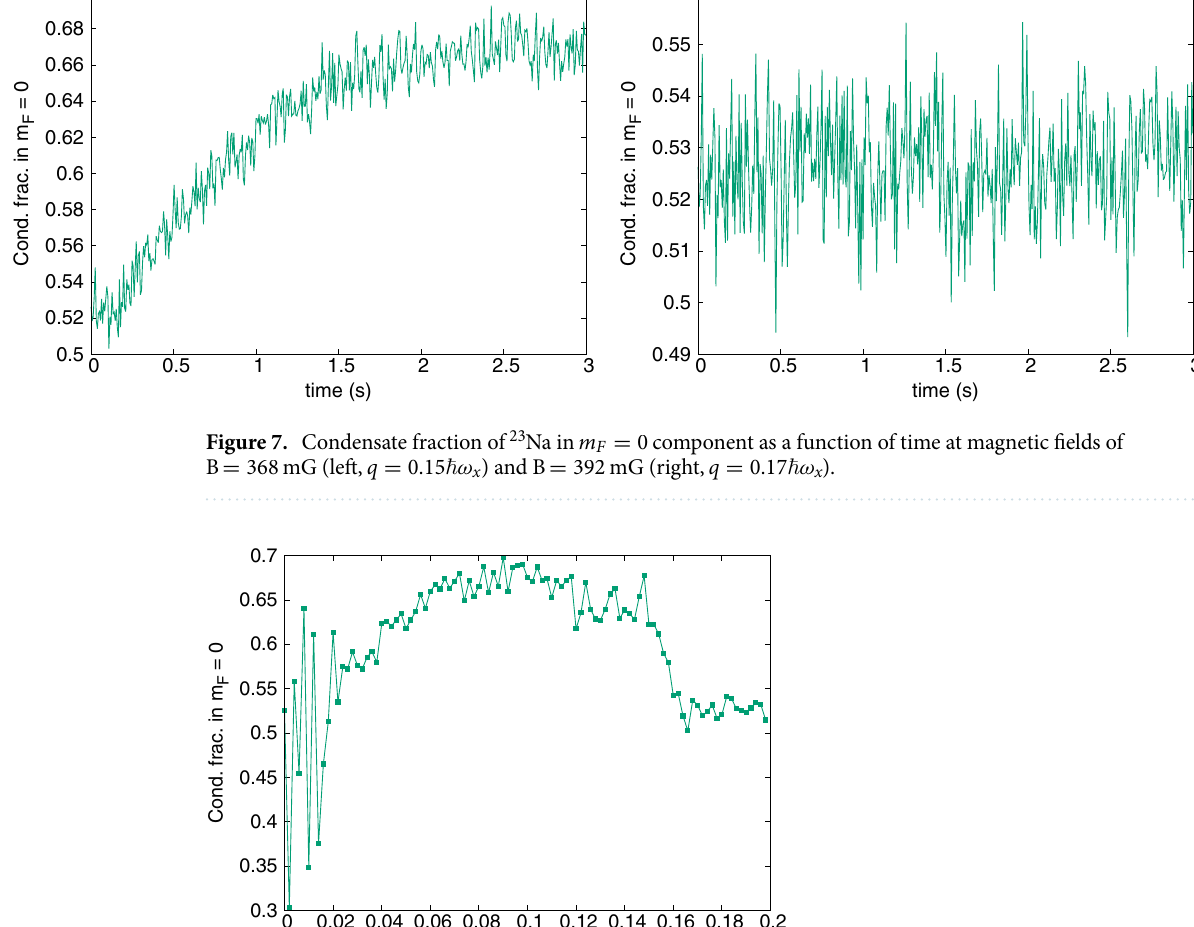
q [osc. un.] 0 after one 1 s cycle, as a function of the applied quadratic Figure 8. Final 23 Na condensate fraction in m F = 0.15 (cid:31) ω x . At the lowest q (cid:31) 0.025 (cid:31) ω x , the 1 s Zeeman energy q / (cid:31) ω x . Cooling ceases suddenly above q = experimentally realistic cycle is too short for stabilisation and the randomness reflects snapshots of different stages of the system’s Rabi cycle at 1 s. An example is seen in Fig. 6, top